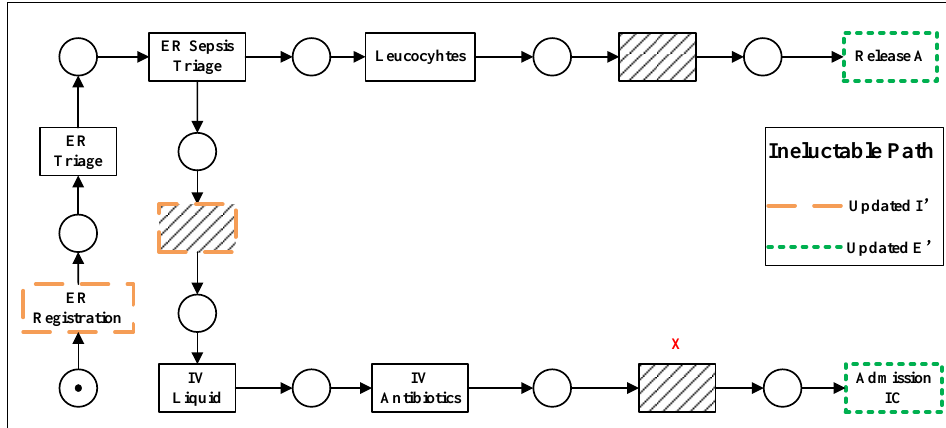
Figure 9. Ineluctable path.